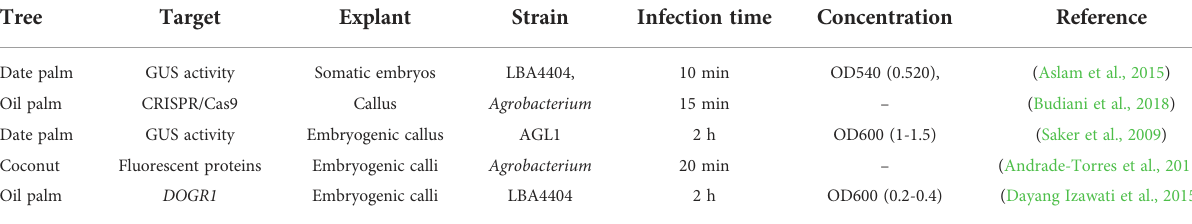
TABLE 2 Agrobacterium -mediated transformation in palm trees.